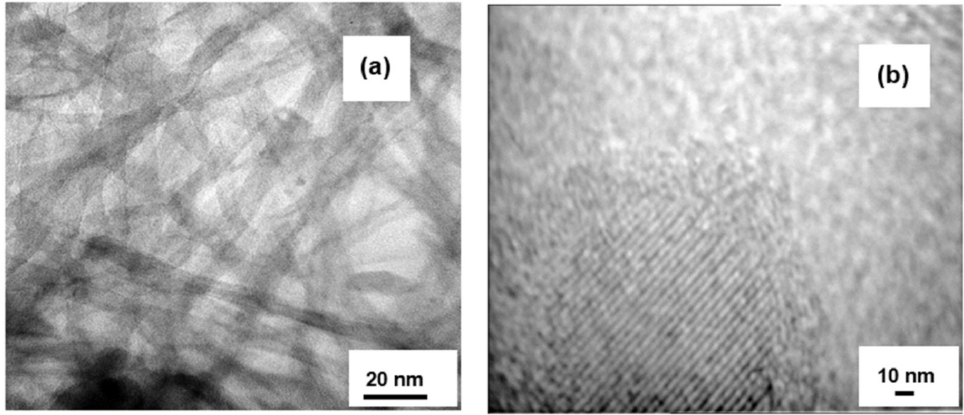
Figure 2. Images of HNT nanotubes with ( a ) TEM and ( b ) HR-TEM. After calcination, the outer and inner diameters of nanotubes decreased to 7–5 nm